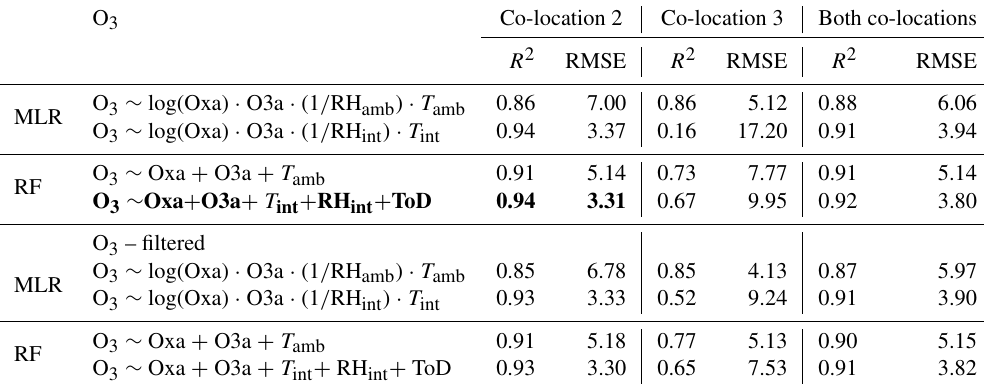
Table 9. Results of RF and MLR models for O 3 trained with co-location 2, co-location 3, or a combination of both when tested on the comparison experimental dataset. In the lower half of the table, the models are trained with the same datasets but are tested on the experimental dataset with data points outside the ranges of each training dataset filtered out. The most accurate model is in